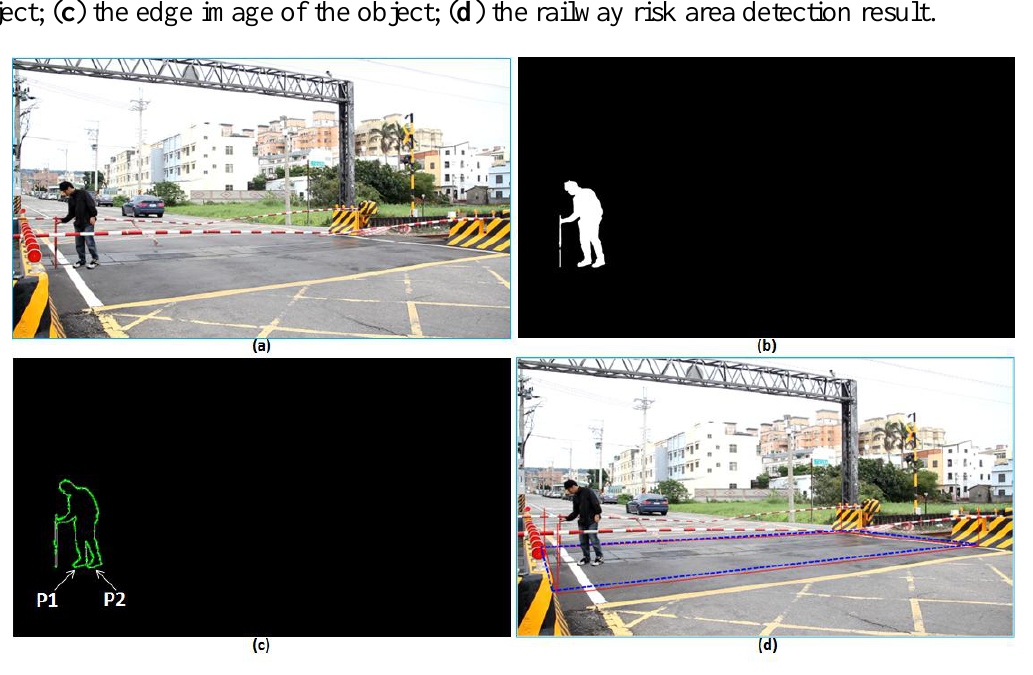
Figure 19. The test image including people taken from NanSikon Road; the blue-line area is the detection result, and the red-line area is the real measured result: ( a ) the original image which is the people are in the railway risk area; ( b ) the people were extracted as an object; ( c ) the edge image of the object; ( d ) the railway risk area detection